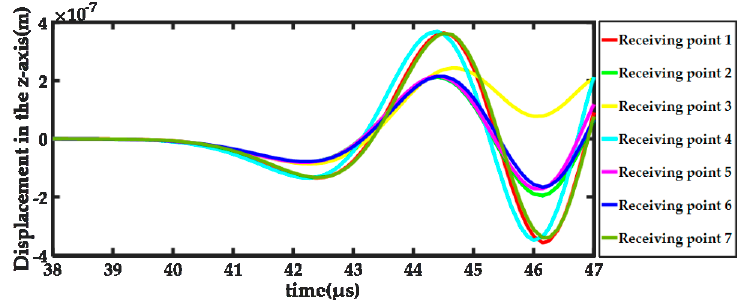
Figure 7. Displacement in the z ‐ axis of each receiving point.